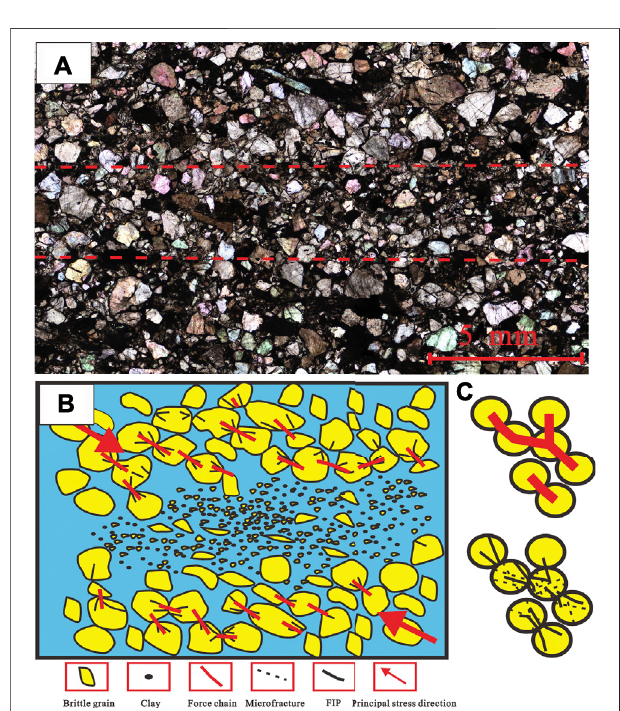
FIGURE 9 | (A) Thin-section photomicrograph of microstructures from the host rock and deformation bands; the boundary is indicated using red dotted lines. (B) Illustration of the relation between maximum principal stress direction,microstructures, and theforce chains. (C) Thegeometryofthe “ Hertzian ” contact, FIP, and geometry of force chains as inferred from grain contact points, modi fi ed from Soliva et al. (2013).